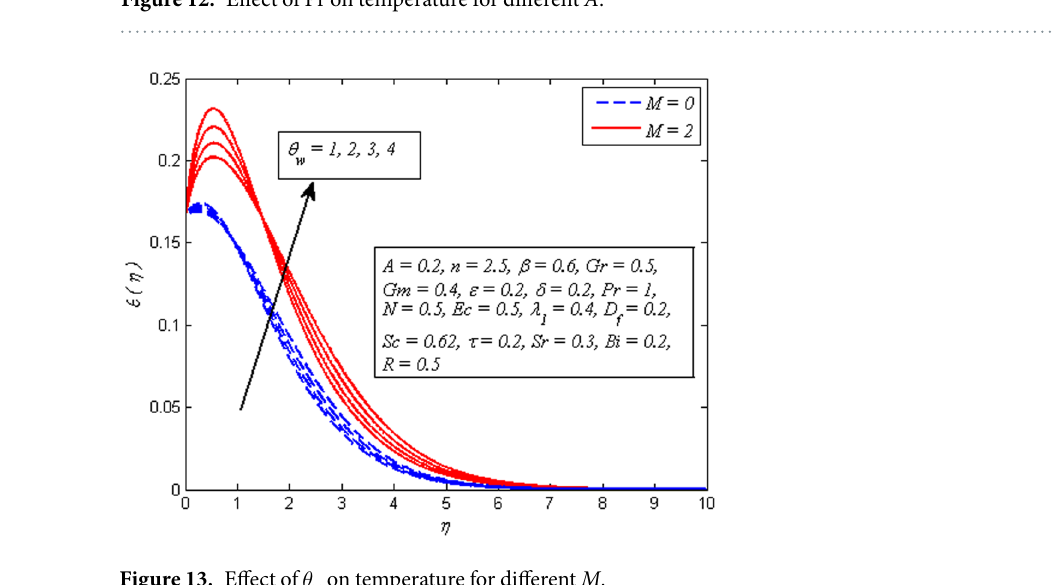
Figure 13. Effect of θ